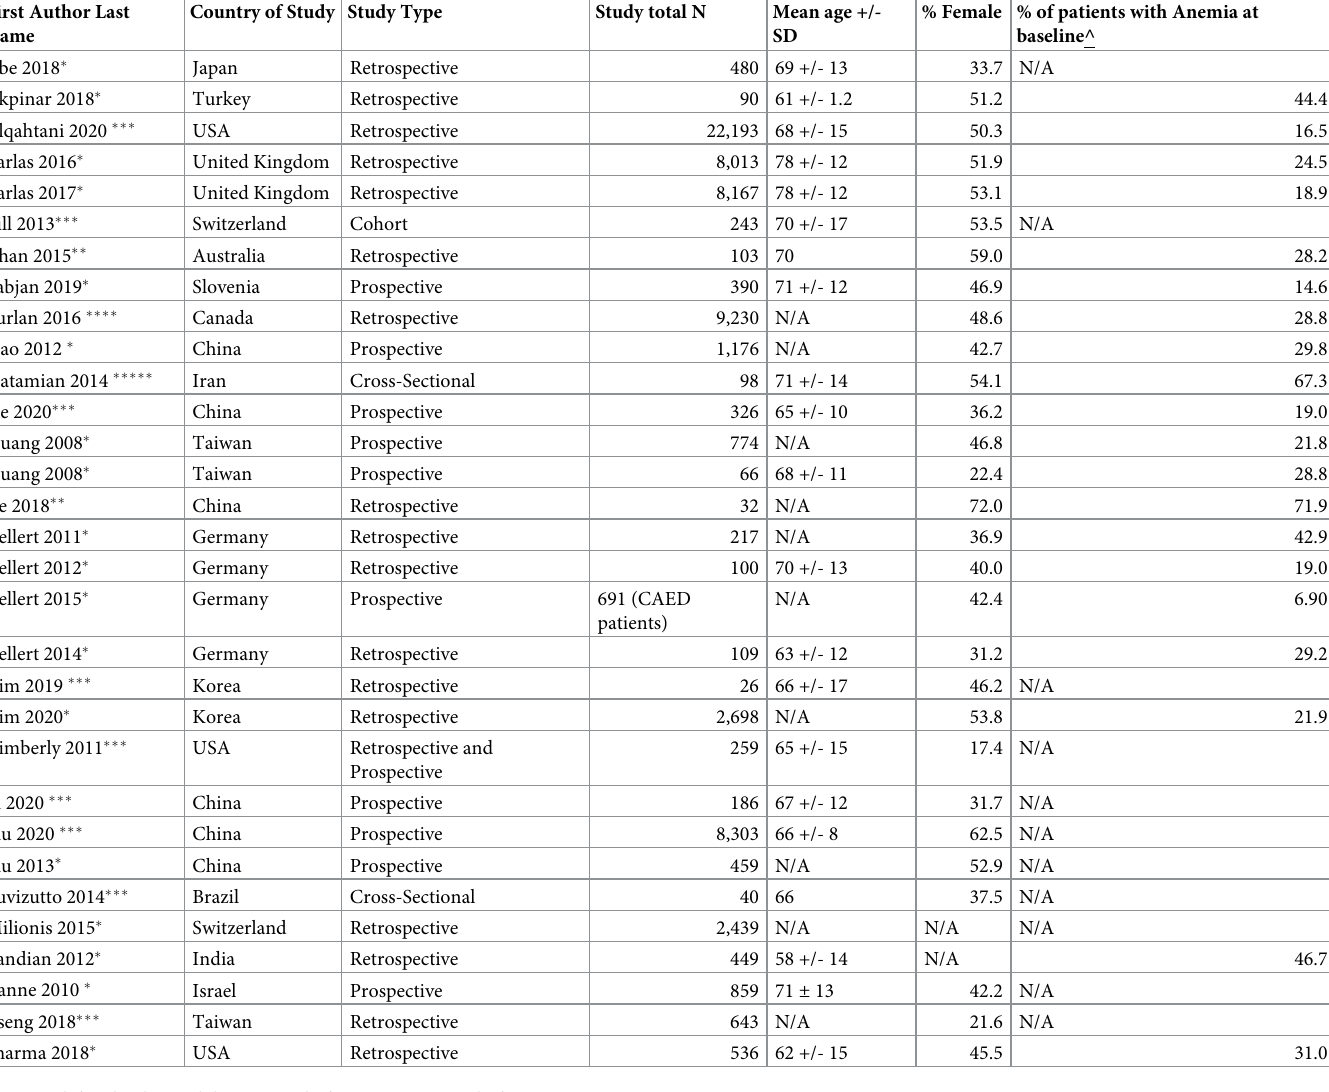
Table 1. Summary of included study